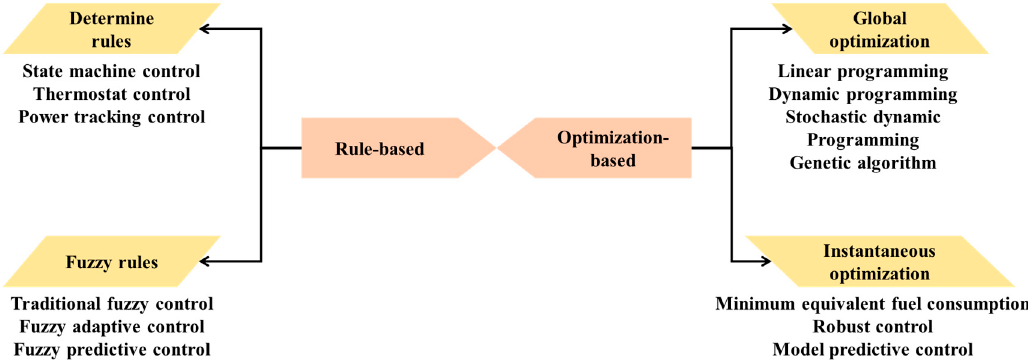
Figure 4. Classification of control strategies.